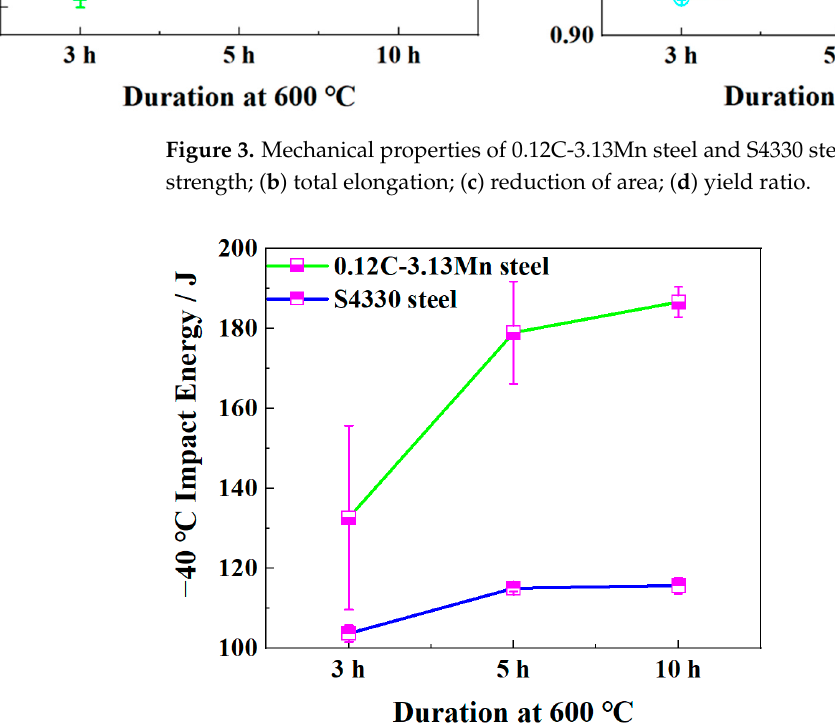
Figure 4. − 40 °C impact energies of the 0.12C-3.13Mn steel and S4330 steel. Figure 4. − 40 ◦ C impact energies of the 0.12C-3.13Mn steel and S4330